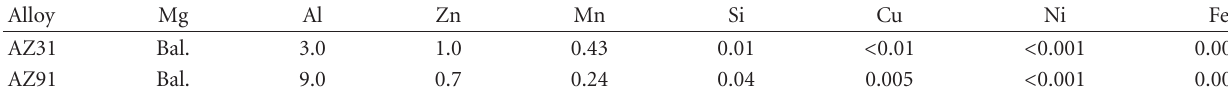
Table 1: Chemical composition (mass %) of AZ31 and AZ91 magnesium alloys.